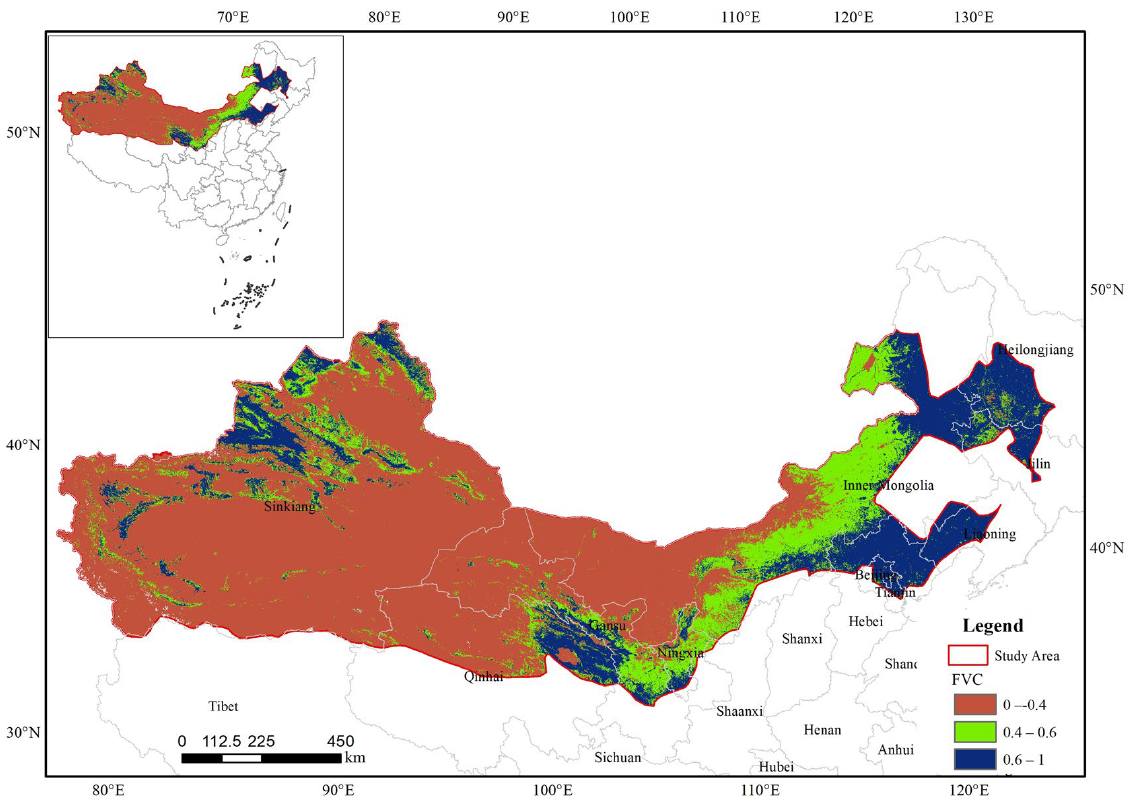
Figure 3. Spatial distribution of vegetation cover in the Three North Protection Forest Project area